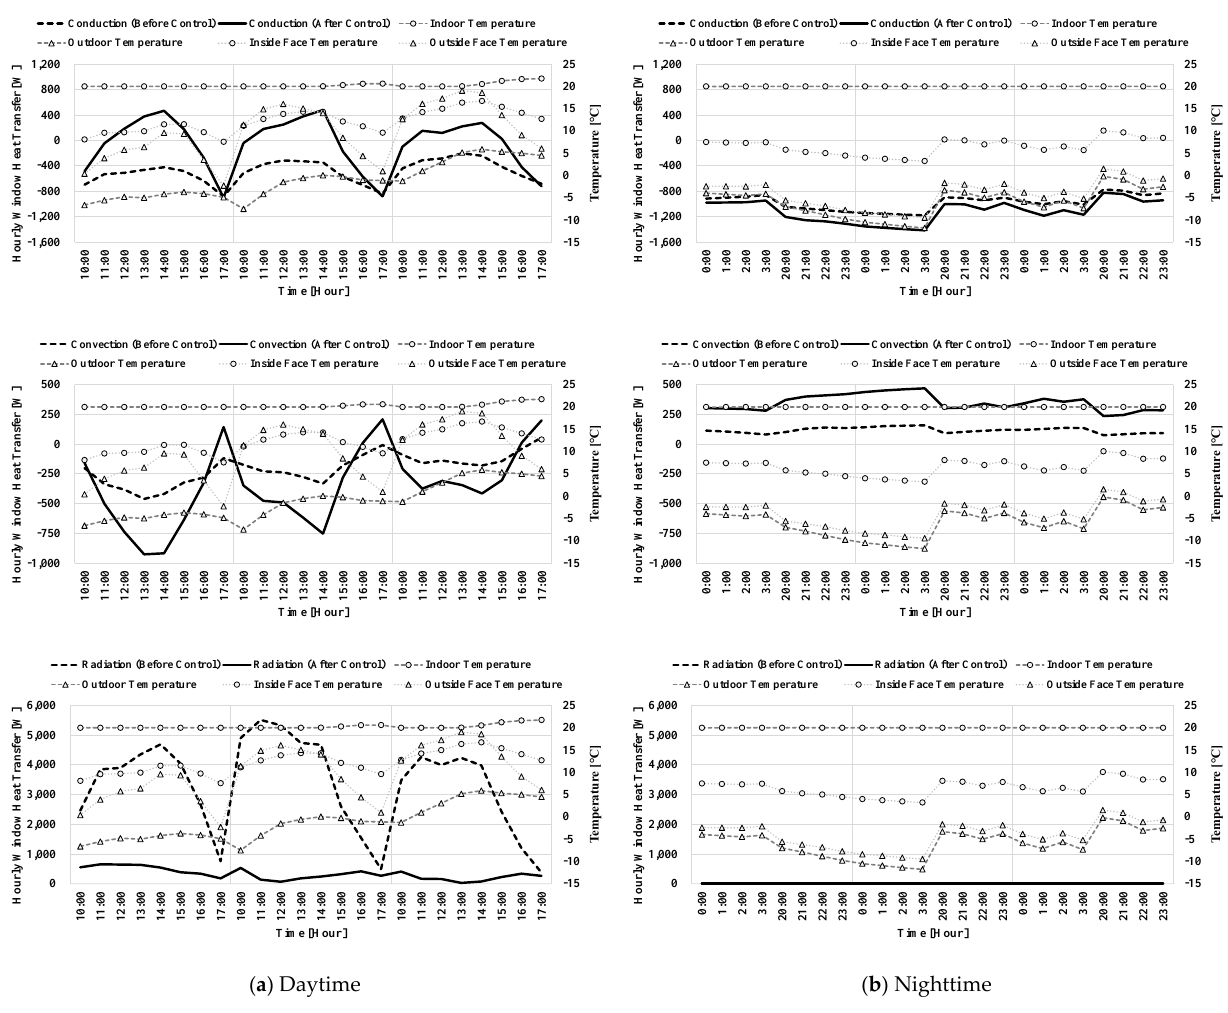
Figure 11. Hourly window heat transfer during the heating period. According to the analysis of the daytime window heat transfer, conduction heat transfer resulted in both heat gain and loss phenomena of approximately 200 to 800 Wh. The reason for this was the changes in the external and internal surface temperatures of the window. Convection heat transfer resulted in a heat loss of approximately 0 to 450 Wh. This result suggests that heat was discharged from inside to outside because the external surface temperature of the window was higher than the outdoor temperature. By contrast, radiation heat transfer decreased from approximately 500 to 4000 Wh. Moreover, unlike the cooling period, in which radiation heat transfer was completely blocked, in this period, radiation heat transfer of approximately 500 Wh was observed. The results indicate that the inflow of solar radiation could help reduce the building heating load during the heating period. According to the analysis of the nighttime window heat transfer, in contrast to the cooling period, a difference was found between conduction and convection heat